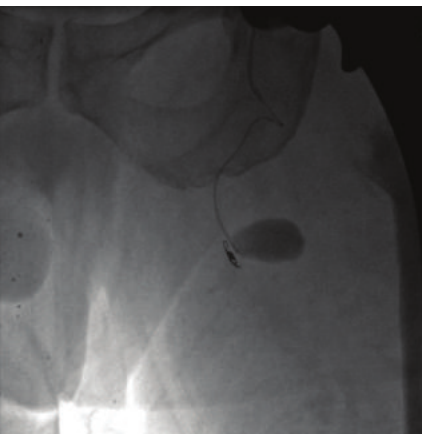
Figure 7: IR angiogram demonstrating 13 mm pseudoaneurysm of the profunda femoris artery.